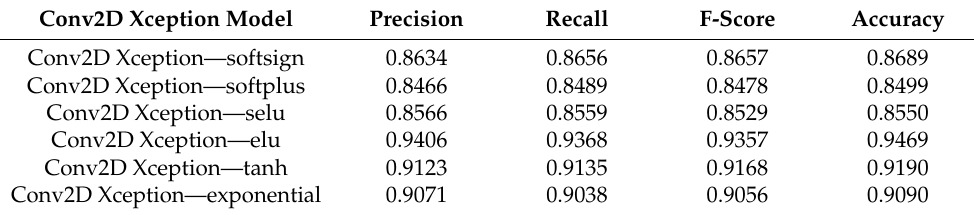
Table 6. Performance analysis for Conv2D Xception model with various activation layers.